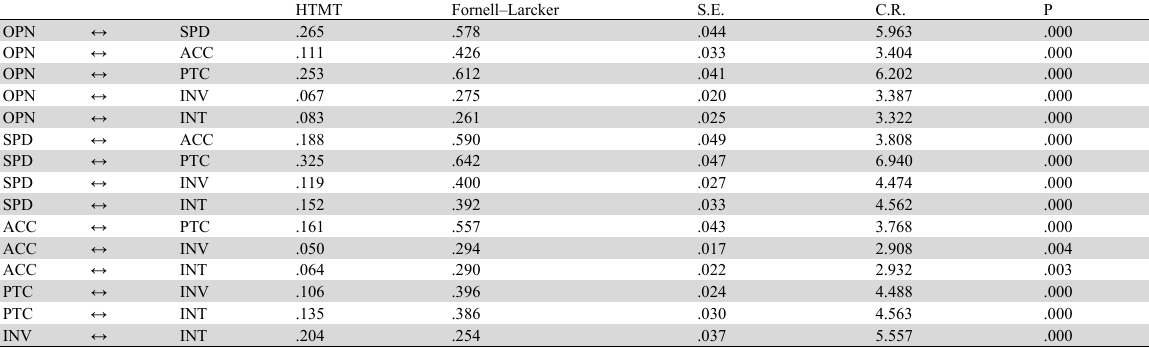
Final CFA Measurement Model – Discriminant Validity HTMT